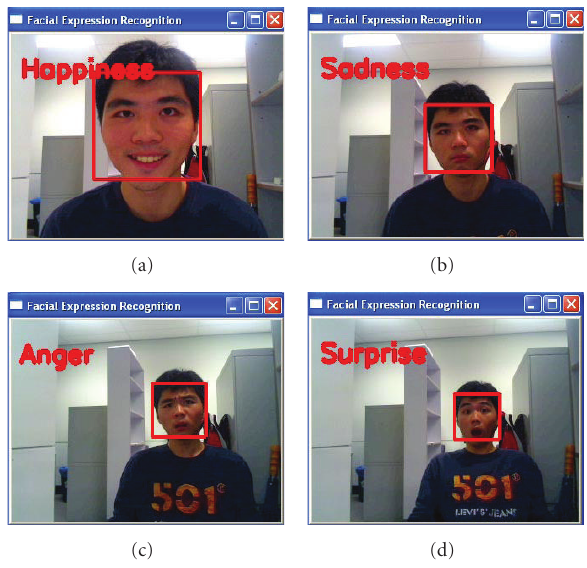
Figure 7: Recognition samples for real-time test.